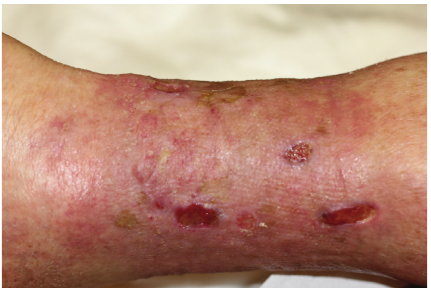
Figure 6: Complete reepithelialization after four months confirmed in follow-up, one year